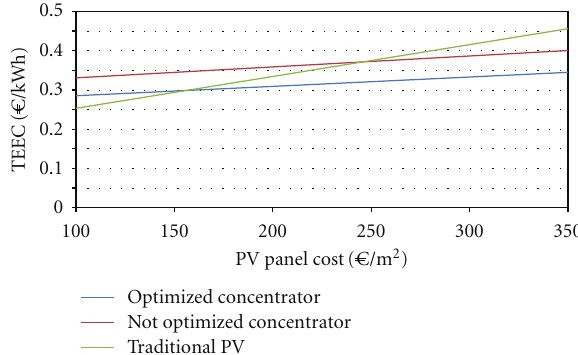
Figure 23: Comparison among TEEC values of the proposed con- centrator (not-optimized and optimized) and the traditional PV system. The comparison is made versus the cost of a monocrys- talline PV